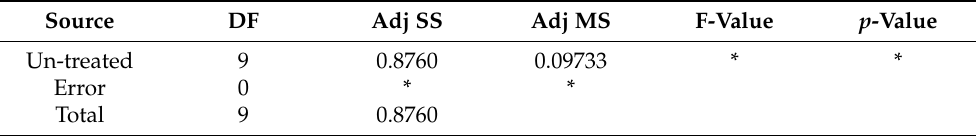
Table 4. Analysis of Variance (ANOVA) of Brinell Hardness for untreated and treated B72 medium- degraded lime.